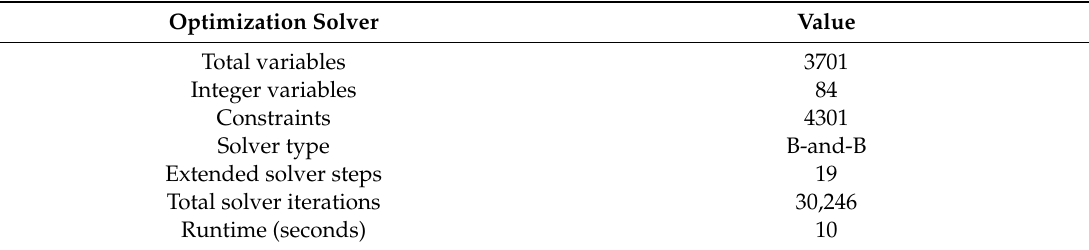
Table 5. Computational information.